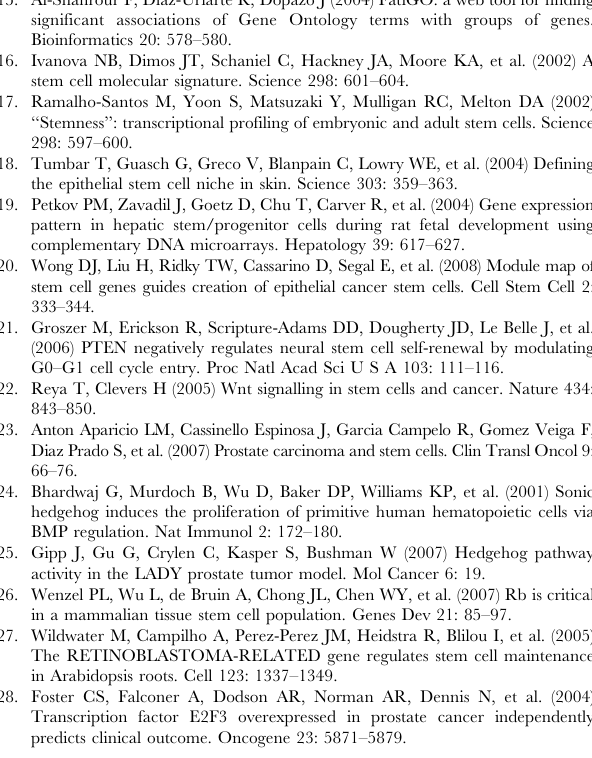
Table S10 Wnt pathway and target genes that are up-regulated in UGE cells. The table presents genes that based on the published literature are known to be either participants or targets of the Wnt pathway. Bolded fonts indicate elevated transcript expression. Table S11 Comparison of gene expression in primitive prostate cell populations as determined by quantitative PCR. qPCR analysis of selected genes from functional categories that were identified in primitive prostate cells. Transcript levels were normalized to the expression of HPRT (housekeeping gene). Data [mean 6 SD] are presented as the fold change of the expression of each gene in UGE, Sca-1Hi or Sca-1Lo cells relative to its expression in Sca-1Neg cells. Table S12 Shh pathway and target genes that are up-regulated in UGE and Sca-1Hi cells. The table presents genes that based on the published literature are known to be either participants or targets of the Shh pathway. Bolded fonts indicate elevated transcript expression.